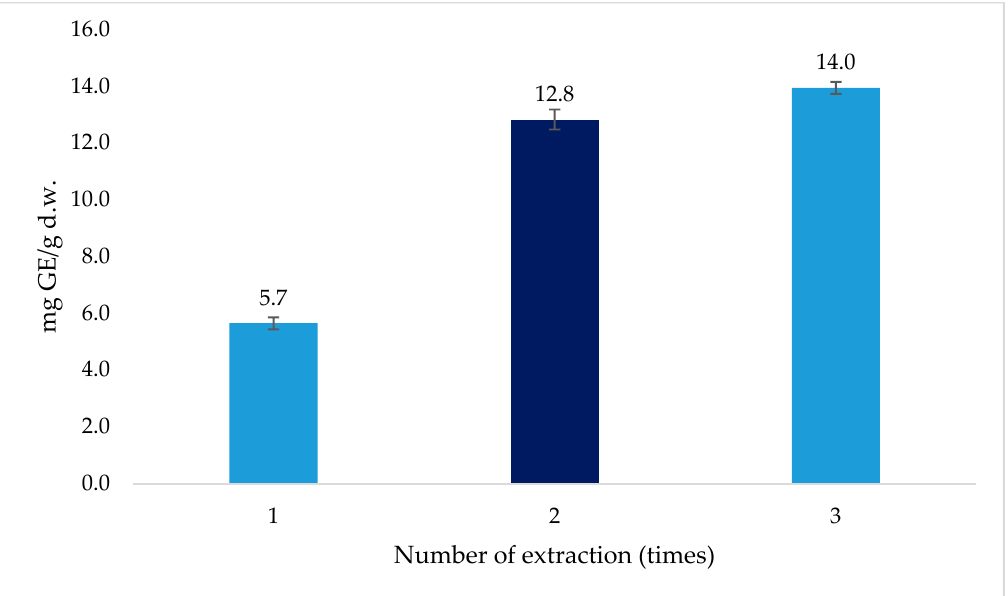
Figure 6. Effect of the number of extraction.